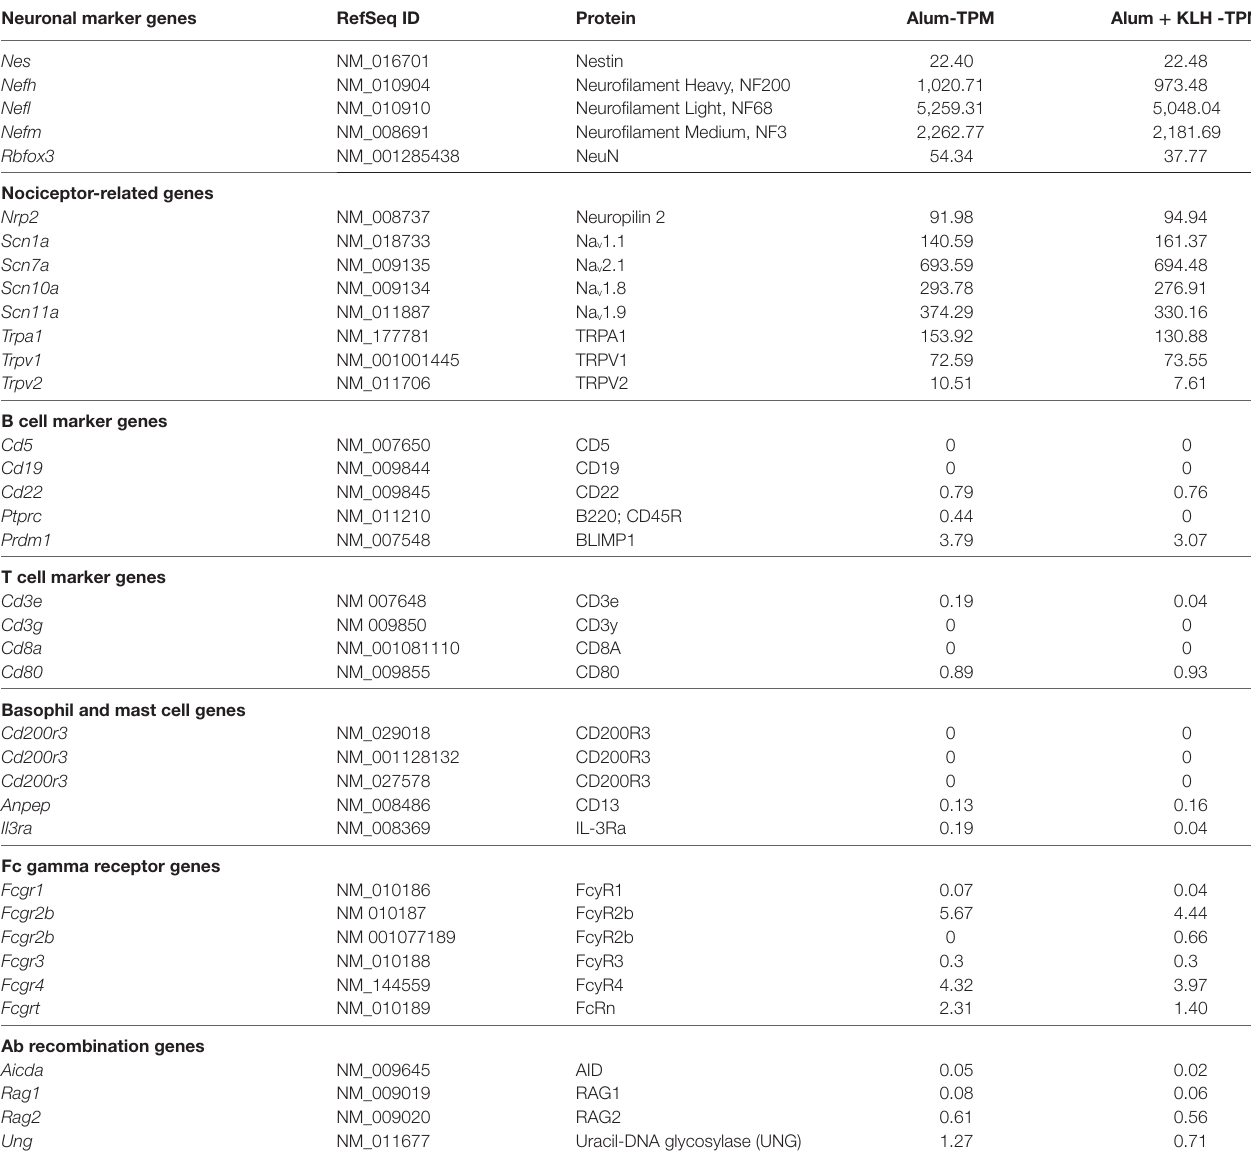
TaBle 2 | Expression of neuron, non-neuron, Fc gamma receptor, and antibody recombination gene expression by